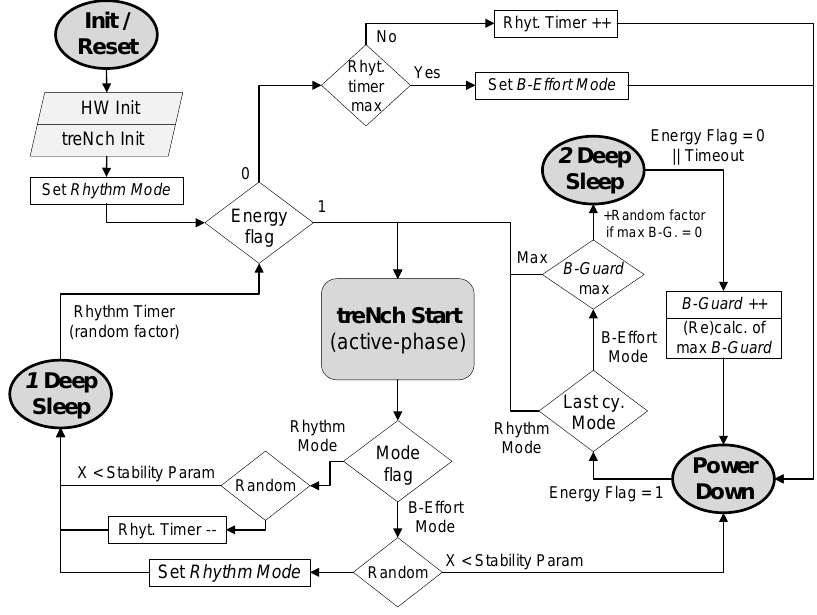
Figure 5. treNch node Sleep Modes and energy optimization algorithm